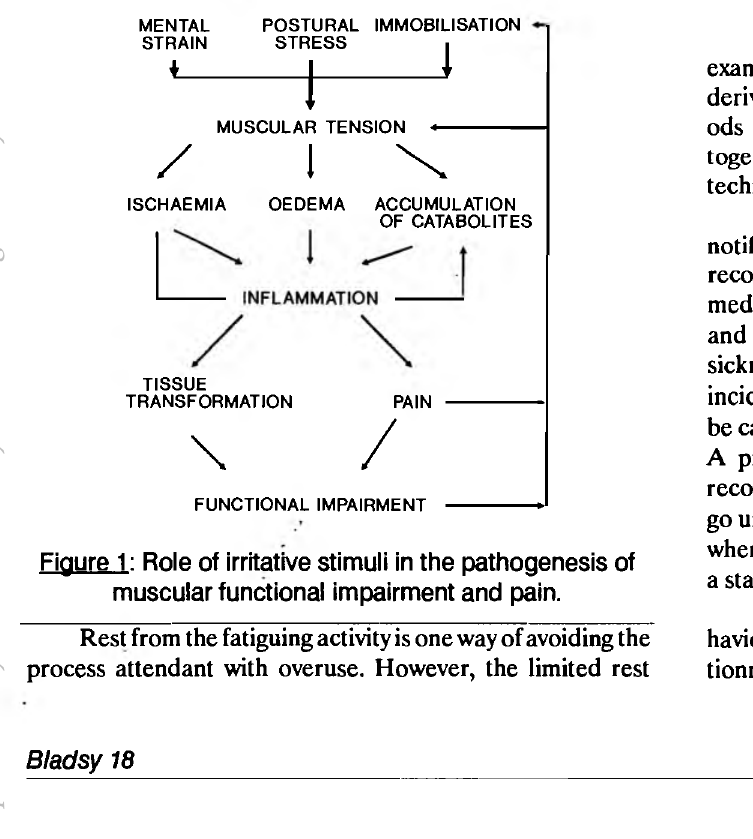
Figure 1: Role of irritative stimuli in the pathogenesis of muscular functional impairment and